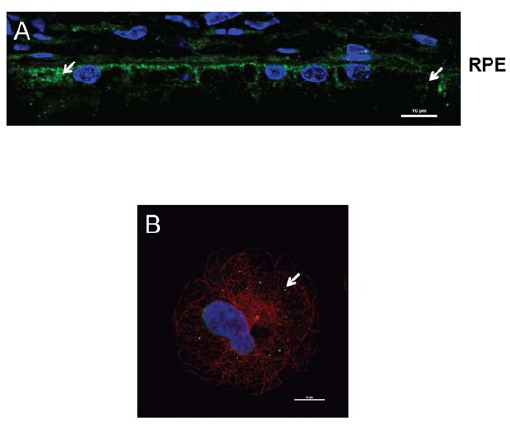
Figure 6. Melanoregulin protein localizes to vesicle-like structures in the RPE cytoplasm. A: Frozen 7 um sections of 4- month-old mouse retinas were stained with anti-Mreg antibody. Nuclei were visualized with DAPI. Images were captured on a Nikon A1R live cell confocal imaging system. B: ARPE19 cells were fixed and stained with anti-MREG mouse mAb, (Novus Biologics) 1:250, anti-alpha tubulin rabbit pAb (Thermo) 1:200, washed and incubated with secondary antibodies: Alexa Fluor 488 donkey anti- mouse IgG (1:1000), Alexa Fluor 594 donkey anti-rabbit (1:1000) and Hoechst 33258 (1:10,000). Images were captured on a Nikon A1R laser scanning confocal microscope with a 100 6 oil objective and processes using Nikon’s Elements software.